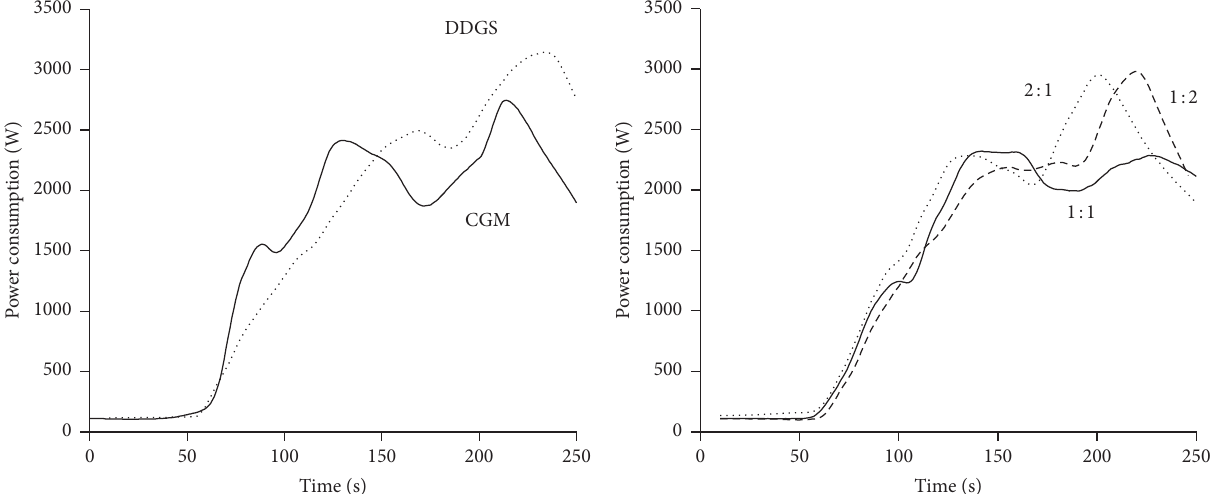
Figure 5: Power consumption during extrusion of CGM and DDGS blends.